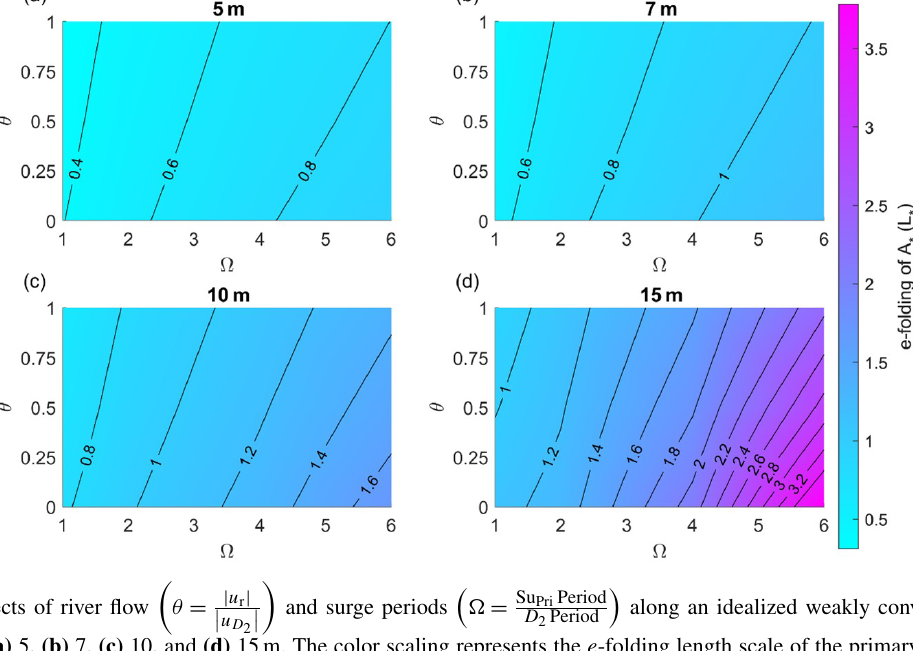
(cid:16) (cid:17) (cid:127) = Su Pri Period along an idealized weakly convergent estuary for D 2 Period